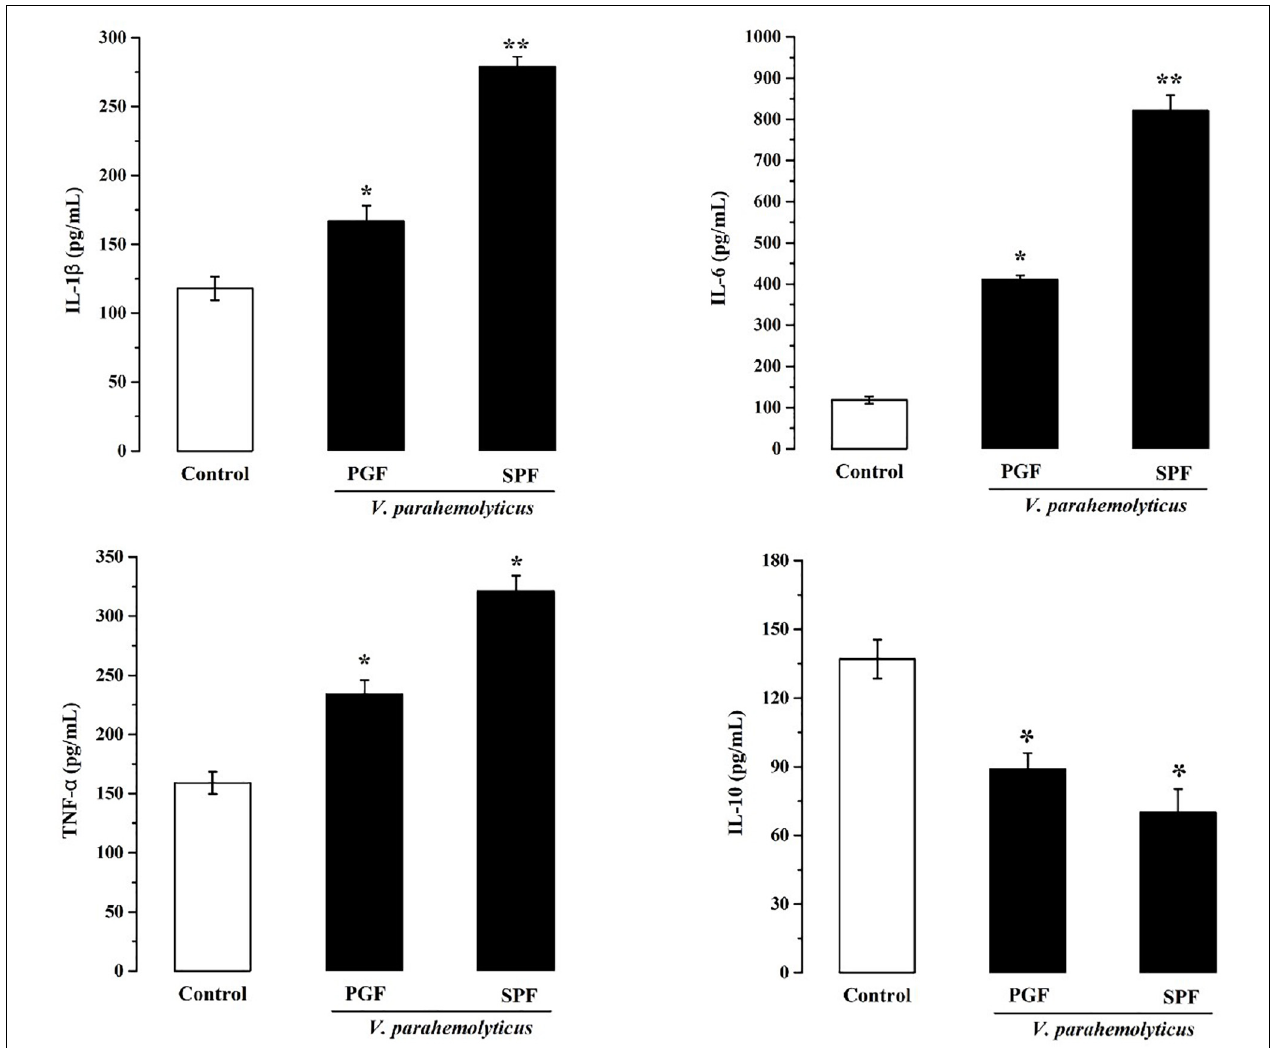
FIGURE 3 | Effects of Vibrio parahaemolyticus on the serum IL-1 β , IL-6, TNF- α , and IL-10 indices of pseudo germ-free mice and normal mice. Data are expressed as the mean ± SEM ( n = 5) compared with the control group gavaged with fresh sterilized LB medium. * p < 0.05; ** p <